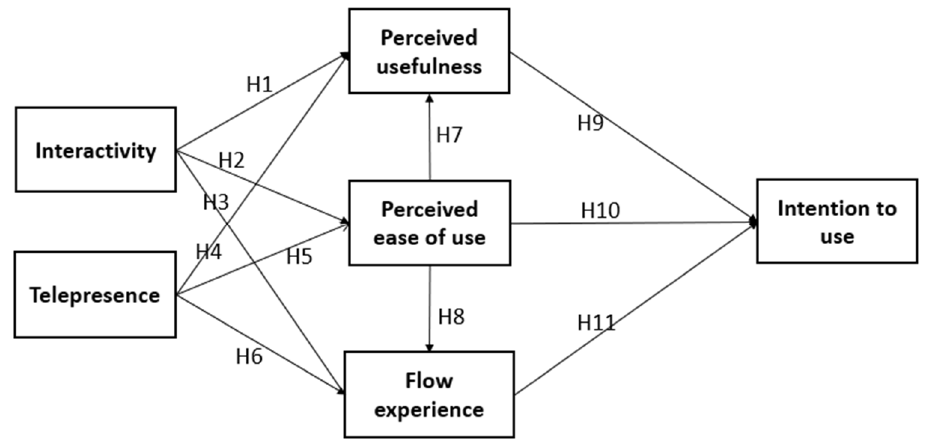
Figure 2. Research model proposed by the authors.